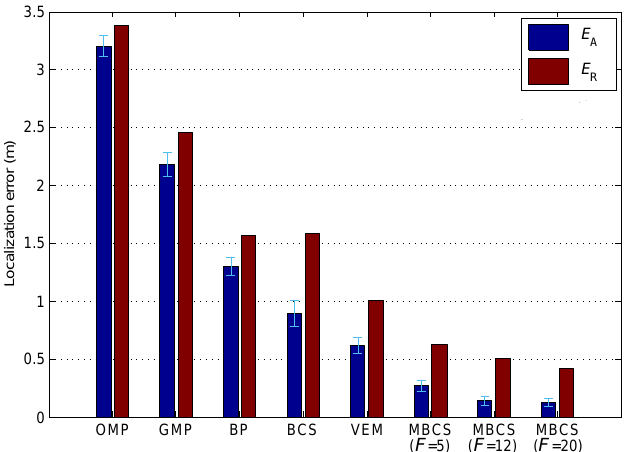
Figure 6. Comparison of localization accuracies for different DFL